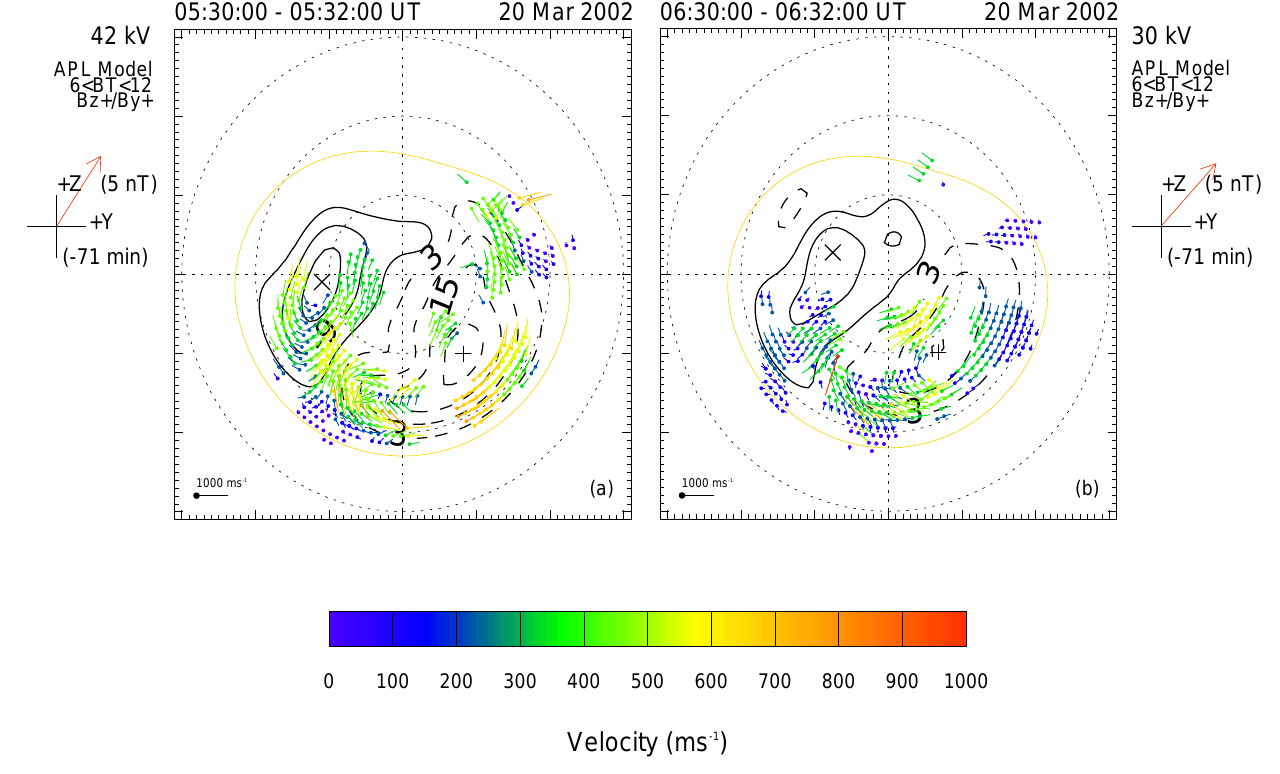
Fig. 4. Flow maps illustrating the overall nature of ionospheric convection during the main interval discussed in this paper. Two maps are shown, the exact time of each being indicated in the top left-hand corner. The total transpolar voltage V PC , and the direction and magnitude (in the Y - Z plane) of the lagged IMF are also indicated, as in Fig.